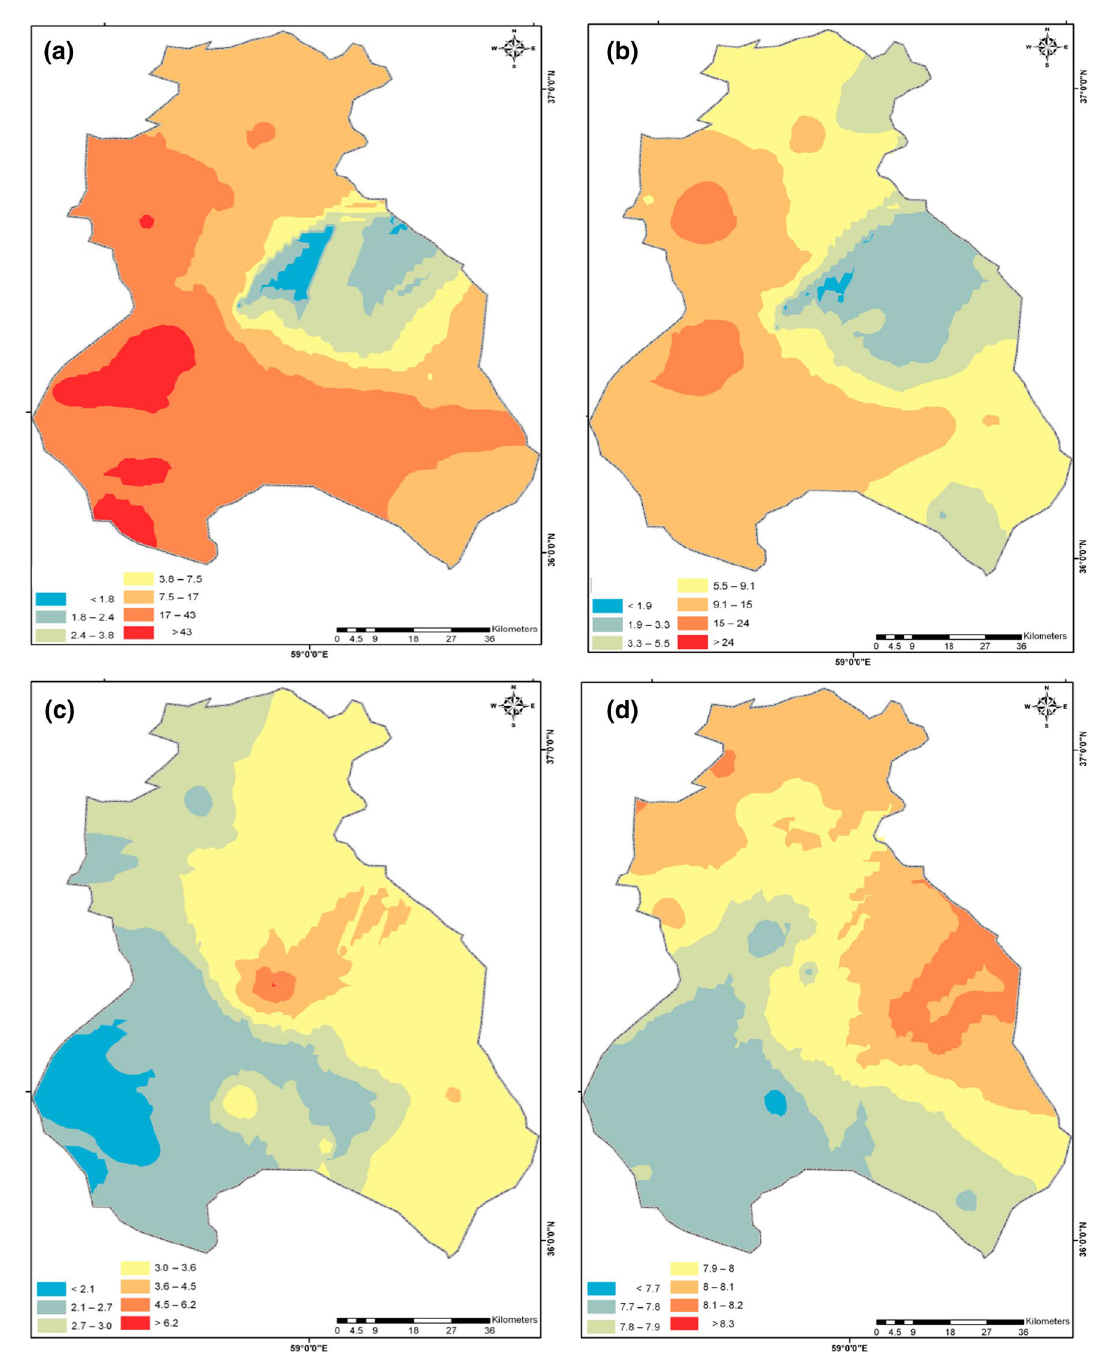
Fig. 4 Spatial distribution of anions. a Chloride (Cl −, mg/l). b Sulfate (SO 42− , mg/l). c Bicarbonate (HCO 3− , mg/l), and d